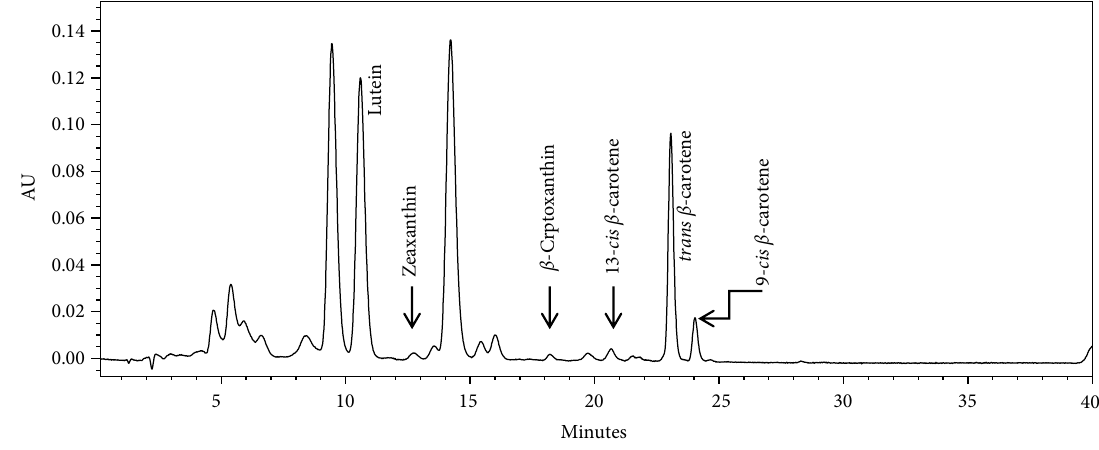
Figure 2: Carotenoids chromatogram for sweet potato